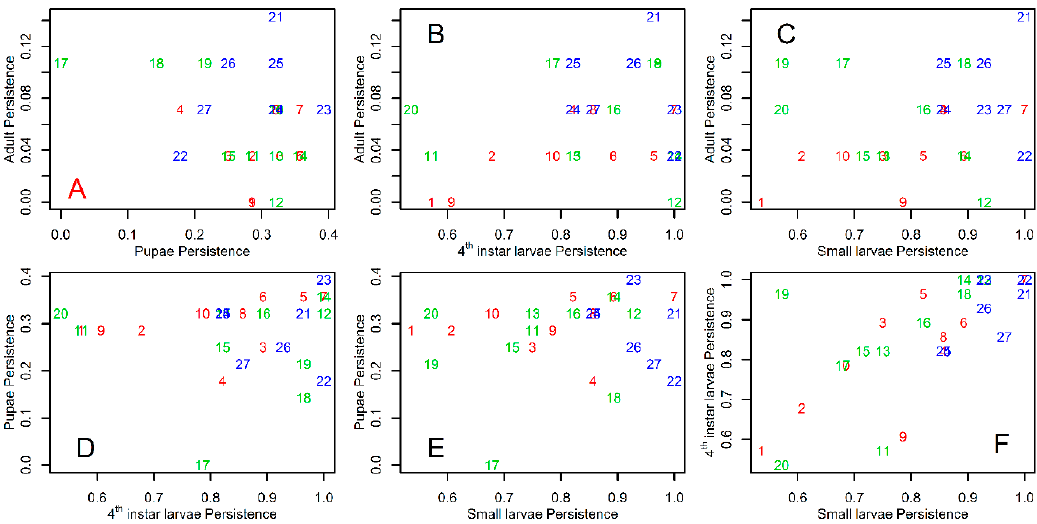
Figure 4. Persistence association among Tripteroides bambusa stages on Mt Konpira, Nagasaki, Japan. Adult persistence as function of ( A ) pupae persistence; ( B ) fourth instar larvae persistence; and ( C ) small larvae persistence. Pupae persistence as function of ( D ) fourth instar larvae persistence; ( E ) small larvae persistence. Fourth instar larvae persistence as function of ( F ) small larvae persistence. In all plots, numbers and colors represent, respectively, the sampling locations and transects described in Figure 2. Table 1. Parameter estimates for the best Poisson model explaining stage persistence of Tripteroides bambusa at Mt. Konpira, Nagasaki, Japan.